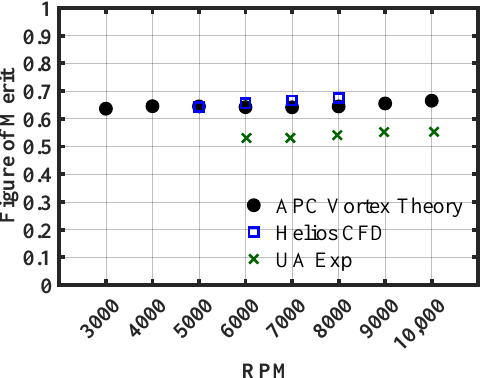
Figure 8. Figure of merit measurements and predictions for the APC8x4.5-MR rotor in